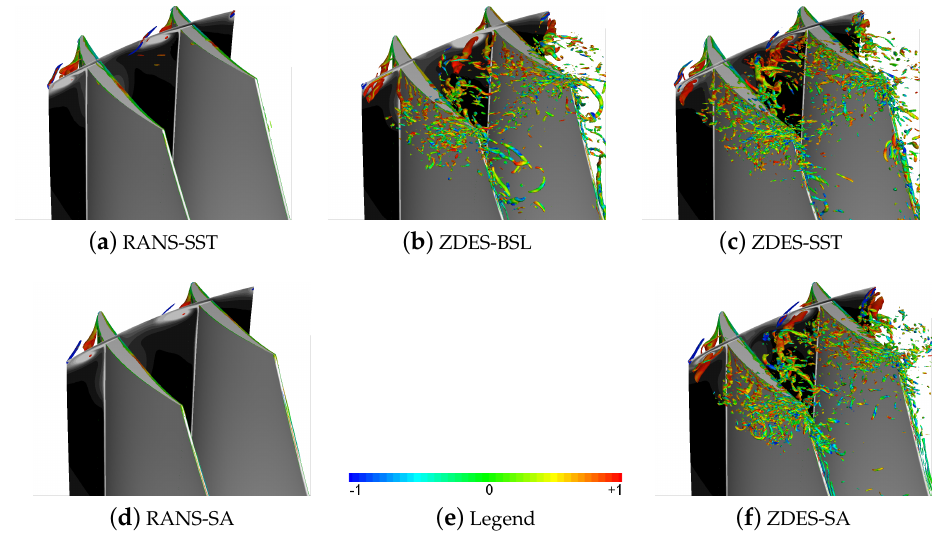
Figure 11. Isosurface of Q criterion colored by normalized helicity and entropy variation field in 31% x/c plane (grey color map). From top to bottom, from left to right: RANS-SST, RANS-SA, ZDES-BSL, ZDES-SST, and